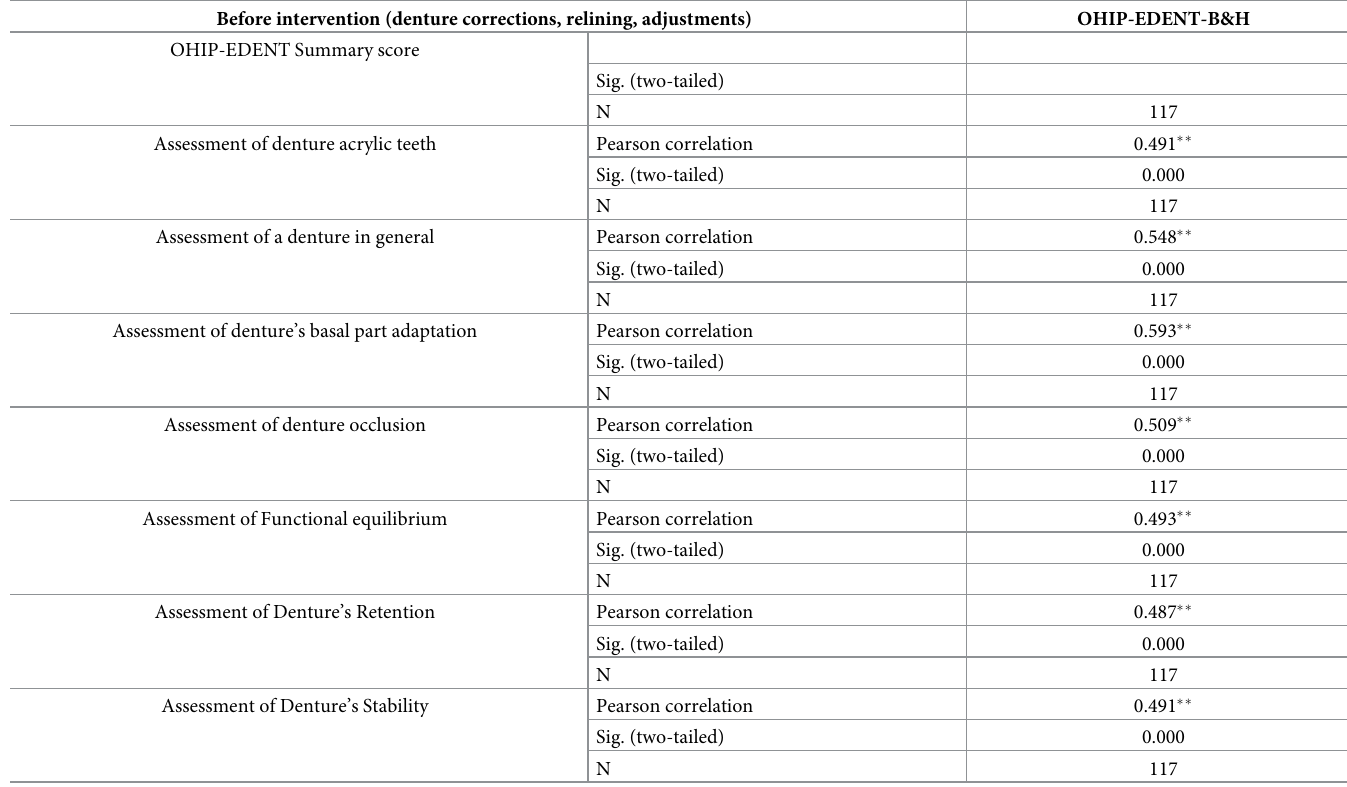
Table 1. Correlation of ohip-edent-B&H summary score and all of domains of this score respecting the assessments of complete dentures before intervention by a specialist of prosthodontics. Before intervention (denture corrections, relining,